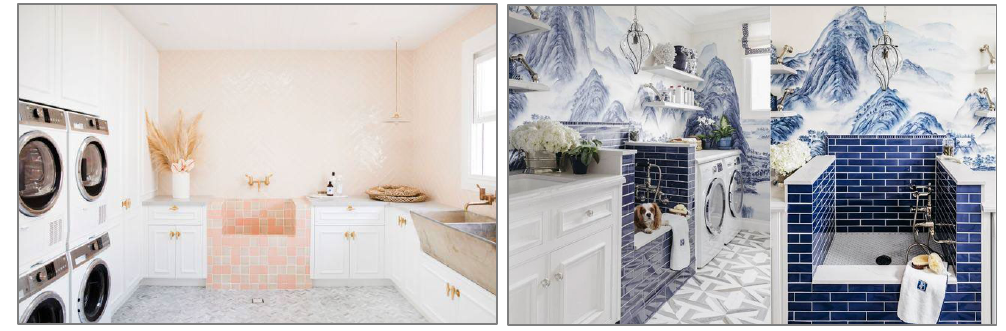
Figure 6-7 Pet wash stations